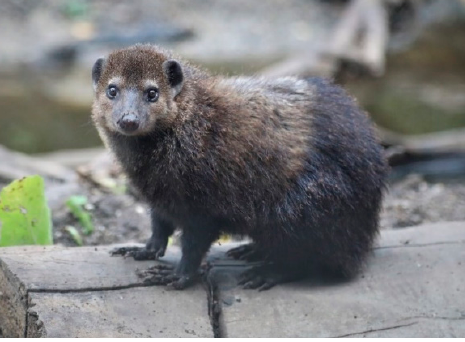
Figure 1. Crossarchus obscurus or common cusimanse. Marwell Zoo, UK.